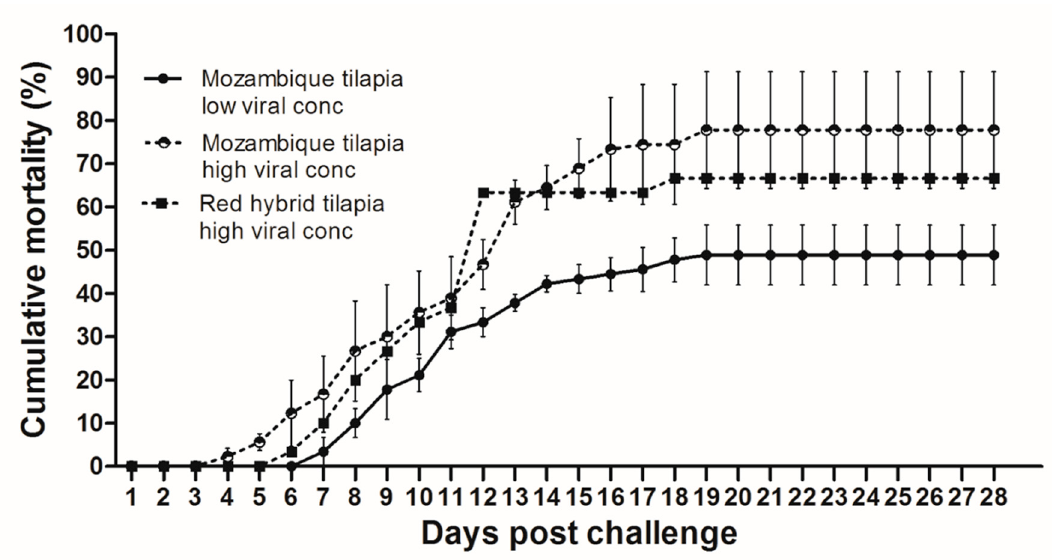
Figure 1. Cumulative mortality after Tilapia lake virus (TiLV) infection in Mozambique tilapia ( Oreochromis mossambicus ) and red hybrid tilapia ( Oreochromis spp.). Fish were intraperitoneally challenged with TiLV at low viral concentration (1 × 10 3 TCID 50 /mL) and high viral concentration (1 × 10 5 TCID 50 /mL) per fish. Graph represents mortality in each group with triplicates, 30 fish per tank (a total of 90 fish/group). Mortality was recorded for 28 days.